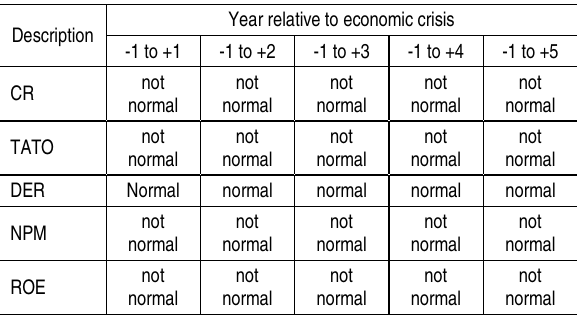
Table 2. Results of tests of data